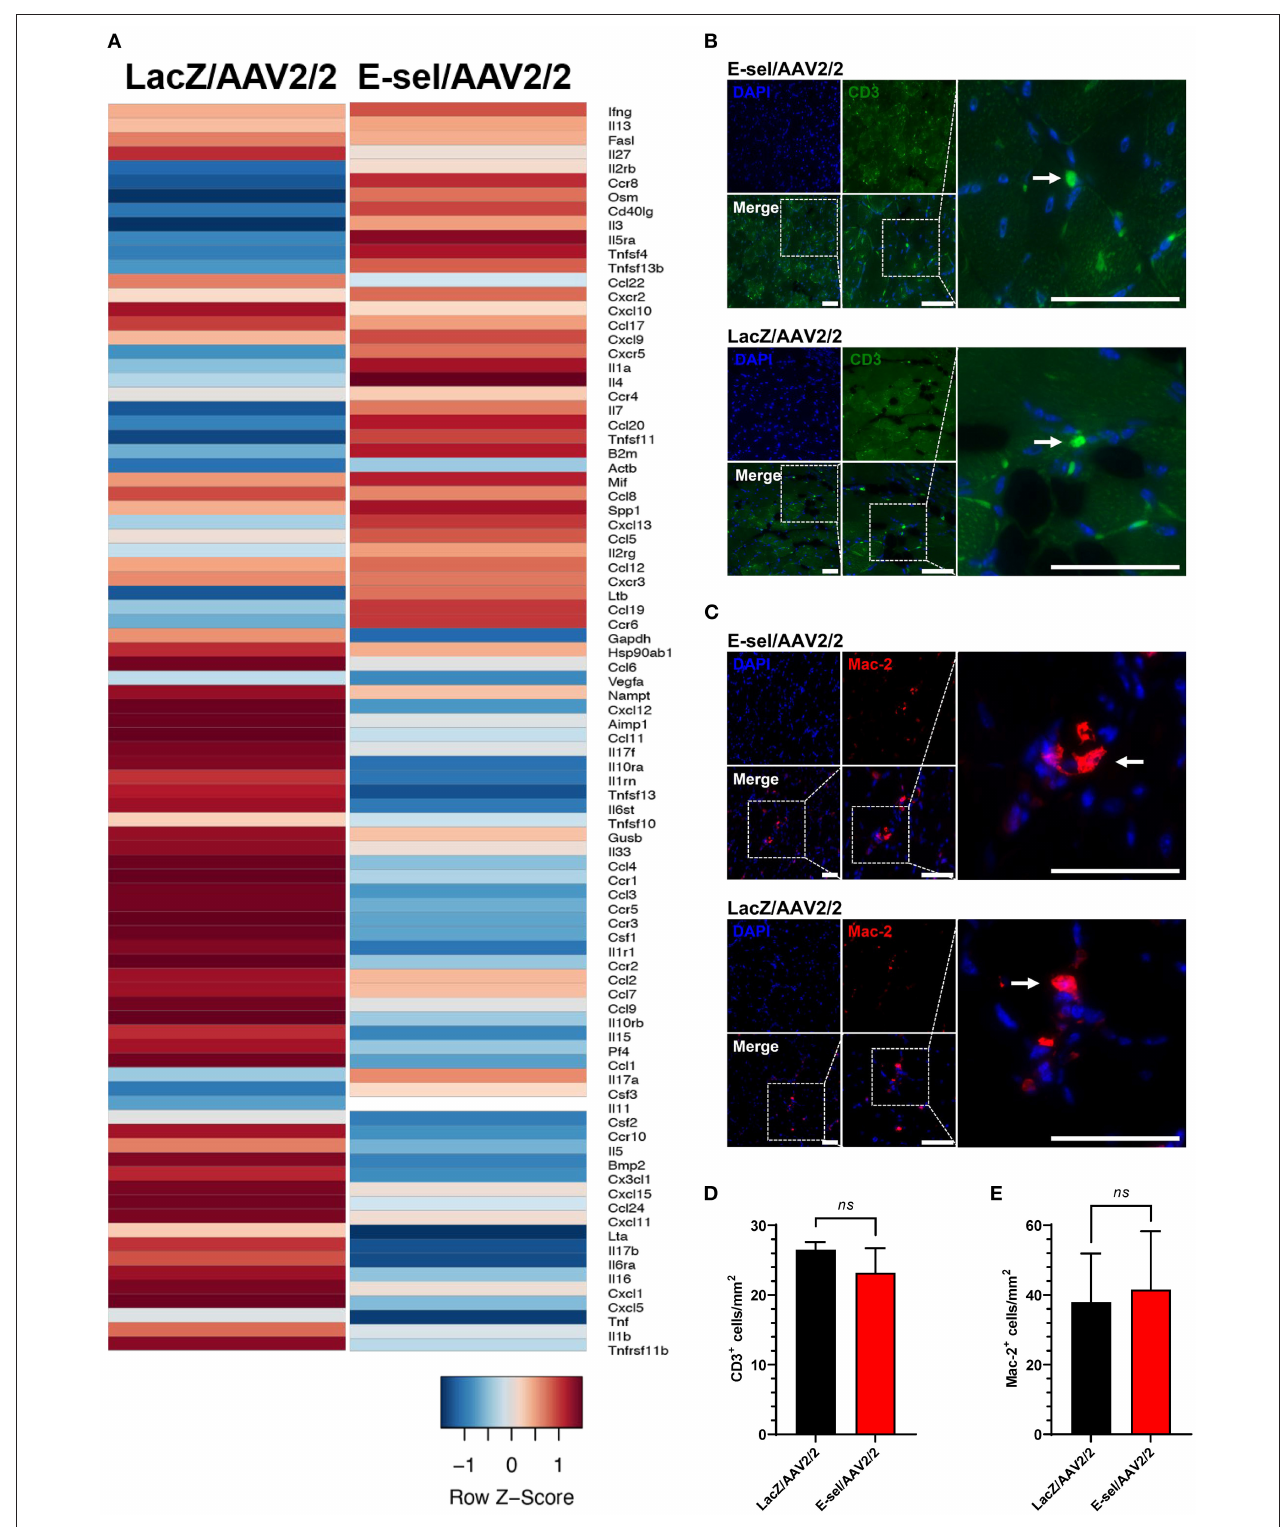
FIGURE 6 | E-sel/AAV2/2 modulates inflammatory gene profile in ischemic muscle without inducing significant inflammatory cell recruitment. (A) PCR array from muscle harvested on POD 21 demonstrating an overall downregulation of inflammatory genes by E-sel/AAV2/2 gene therapy. (B) Representative immunofluorescence images of ischemic muscle stained for CD3, a marker of T cells (pointed arrowheads), and (C) Mac-2/Galectin-3, a marker of macrophages (pointed arrowheads). (D) Counting of CD3 + and (E) Mac-2 + cells demonstrating no significant difference in T cell or macrophage recruitment to ischemic muscle treated with E-sel/AAV2/2 and LacZ/AAV2/2. Scale bars represent 50 µ m. Data are presented as mean ± SEM and ns , not significant ( P > 0.05).